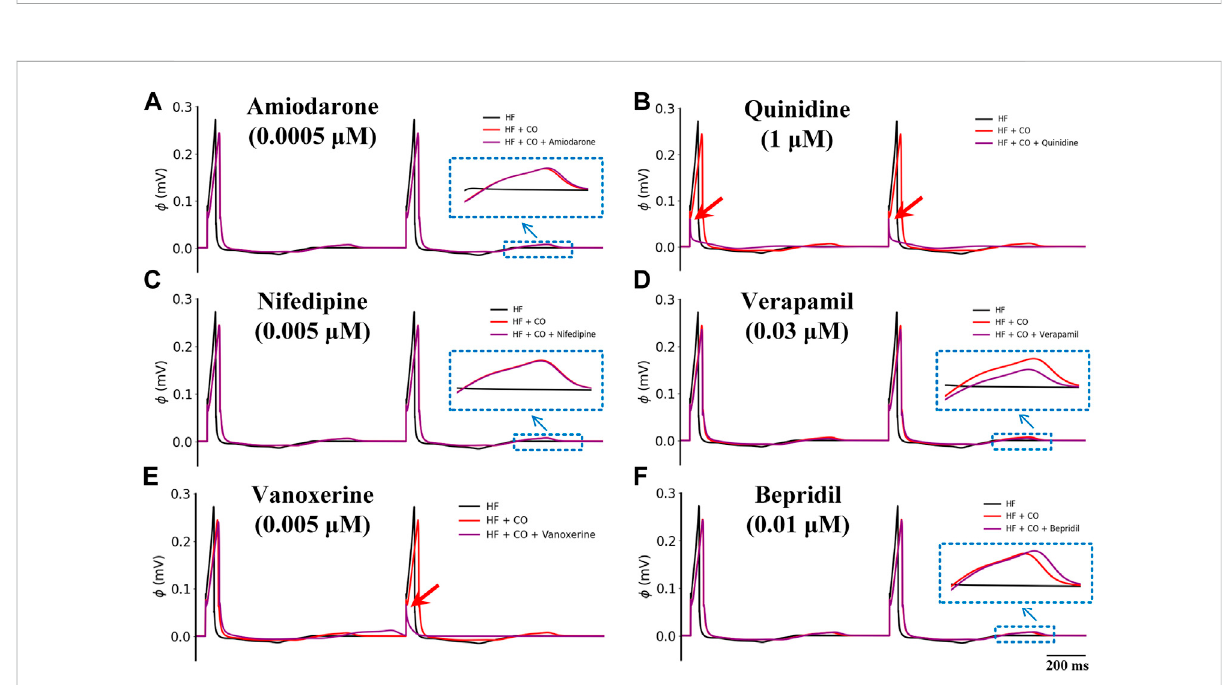
FIGURE 9 Effects of six multi-channel blockers on CO-affected ECG morphology by heart failure (HF). ECG morphology of (A) amiodarone (0.0005 μ M), (B) quinidine (1 μ M), (C) nifedipine (0.005 μ M), (D) verapamil (0.03 μ M), (E) vanoxerine (0.005 μ M) and (F) bepridil (0.01 μ